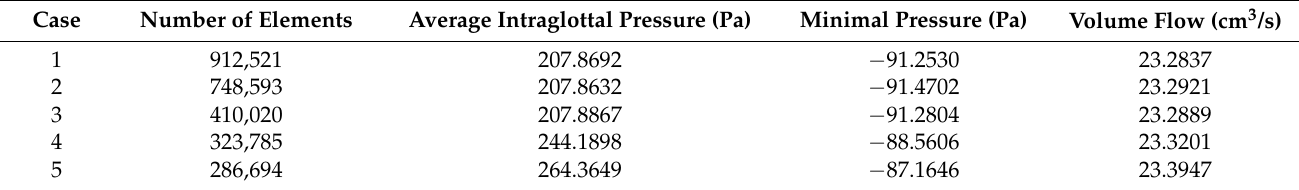
Table 1. Results of the grid independence